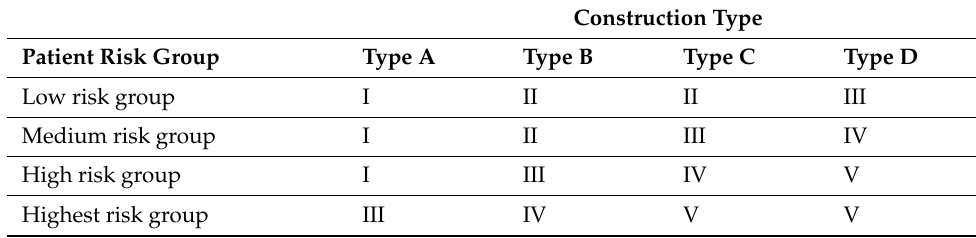
Table 3. ICRA precaution matrix—class of precautions according to construction type and patient risk group. Author’s adaptation of